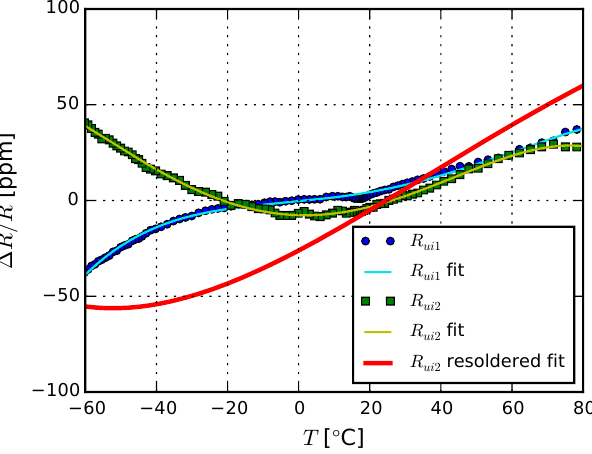
Figure 9. VSMP0805 resistors temperature